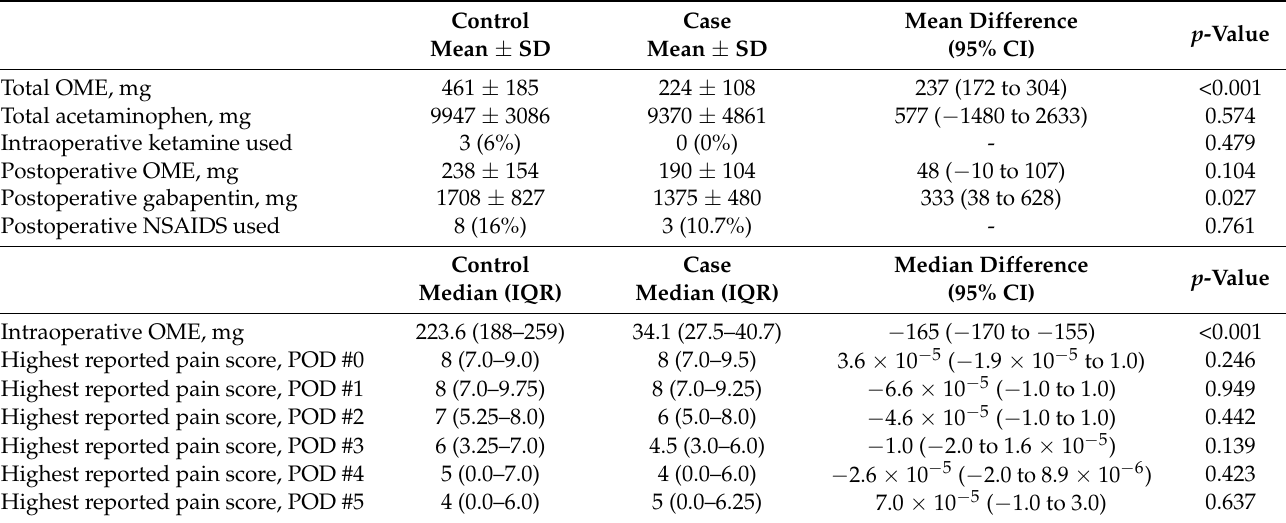
Table 2. Analgesic consumption and pain scores.